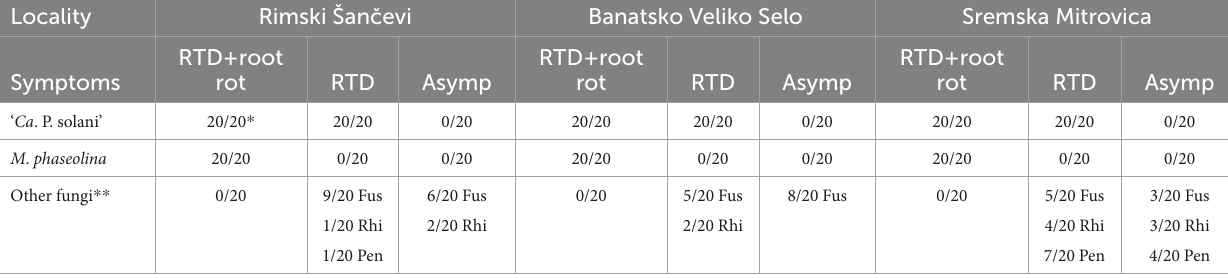
TABLE 2 Sugar beet root symptoms and presence of ‘ Ca . P. solani’ and M . phaseolina in the open field. Locality